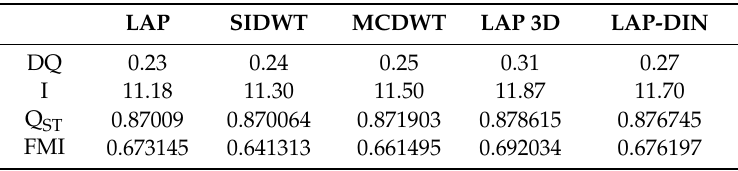
Table 3. Results of four objective measures on dataset sequences.